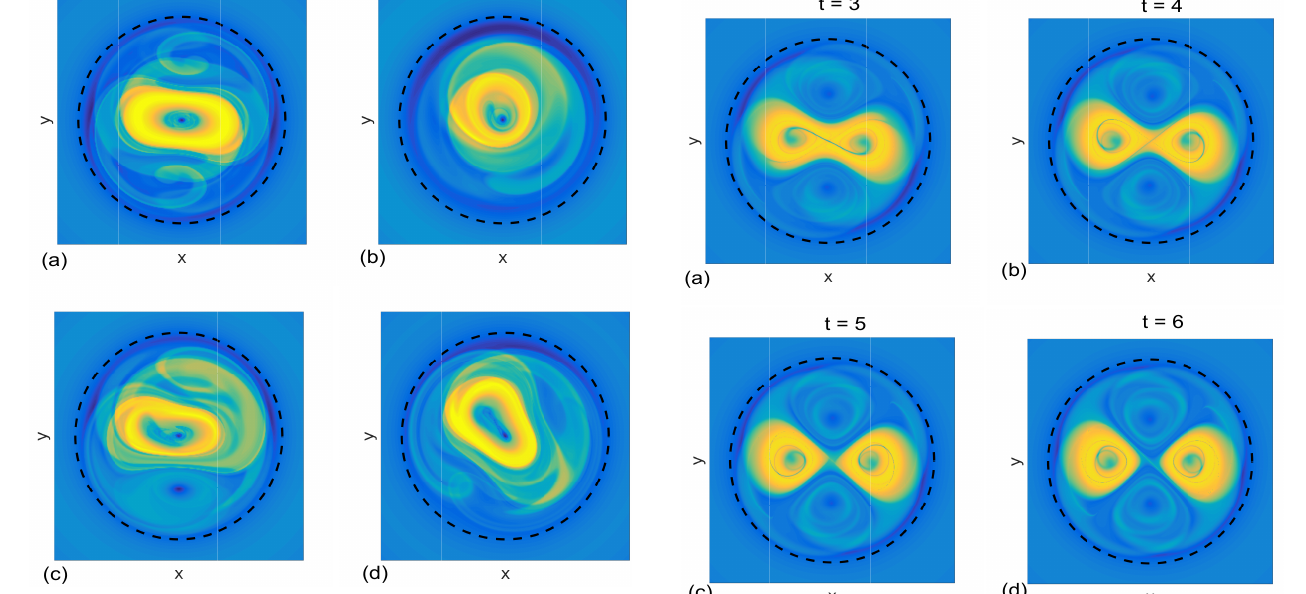
Figure 9. Evolution of the Lagrangian template for the case in which the mean flow decreases and wave 2 increases. The sequence reproduces many of the Lagrangian features observed in the split- ting event that occurred at the end of September 2002 (see movie S5). (a) t = 3; (b) t = 4; (c) t = 5; (d) t =